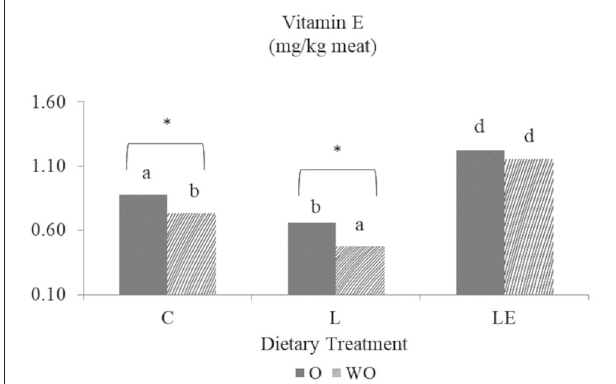
FIGURE 5 | Effect of experimental diets (C, L, and LE) on Vitamin E concentration on Marchigiana beef meat treated with (O) and without essential oils (WO) at 9 days of storage. Different letters on top of bars denote significant differences ( P < 0.05) between different dietary treatments (C, L, and LE). Asterisk denotes significant differences in the same group between the meat with (O) and without essential oils